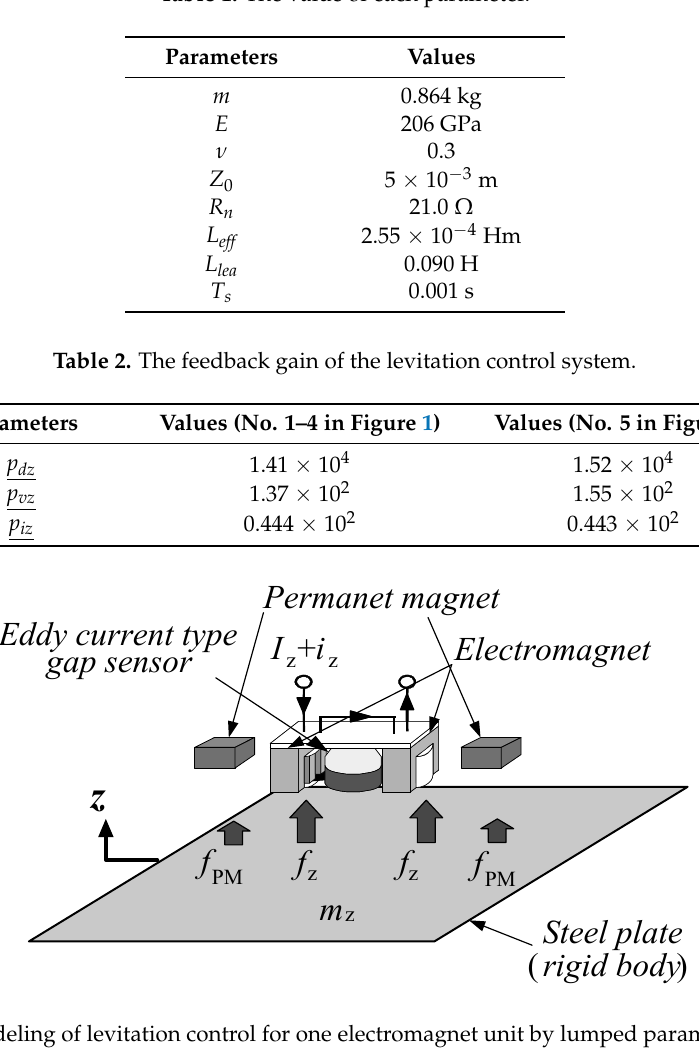
Table 1. The value of each parameter.